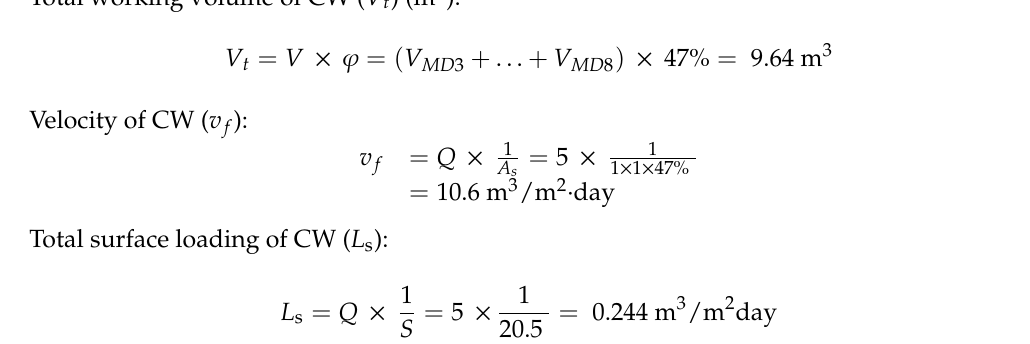
Figure 1. ( a ) Cross section, and ( b ) design parameters of the treatment system.